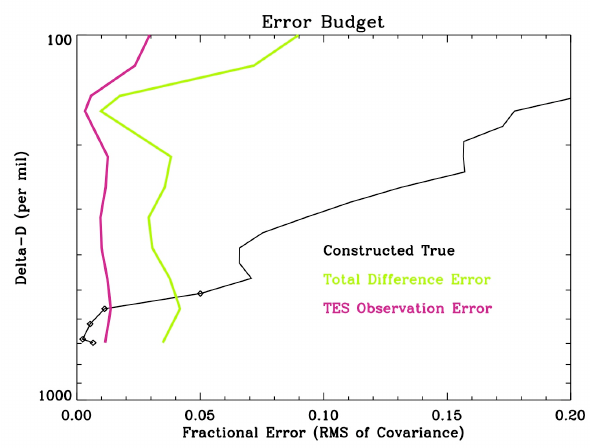
Fig. 7. Error budget for the TES and in situ data comparison for 20 October 2008. The diamonds are the pressure levels corresponding Figure 7: Error budget for the TES and in situ data comparison for Oct. 20 2008. The to in situ measurements. The black line is the total error for the diamonds are the pressure levels corresponding to in situ measurements. The black line is constructed true profile. The red line is the observation error (noise the total error for the constructed true profile. The red line is the observation error (noise + interfering species) for the TES estimate. The green line is the + interfering species) for the TES estimate. The green line is the error in the difference error in the difference between the TES estimate and the true profile between the TES estimate and the true profile after accounting for the TES sensitivity. after accounting for the TES sensitivity.